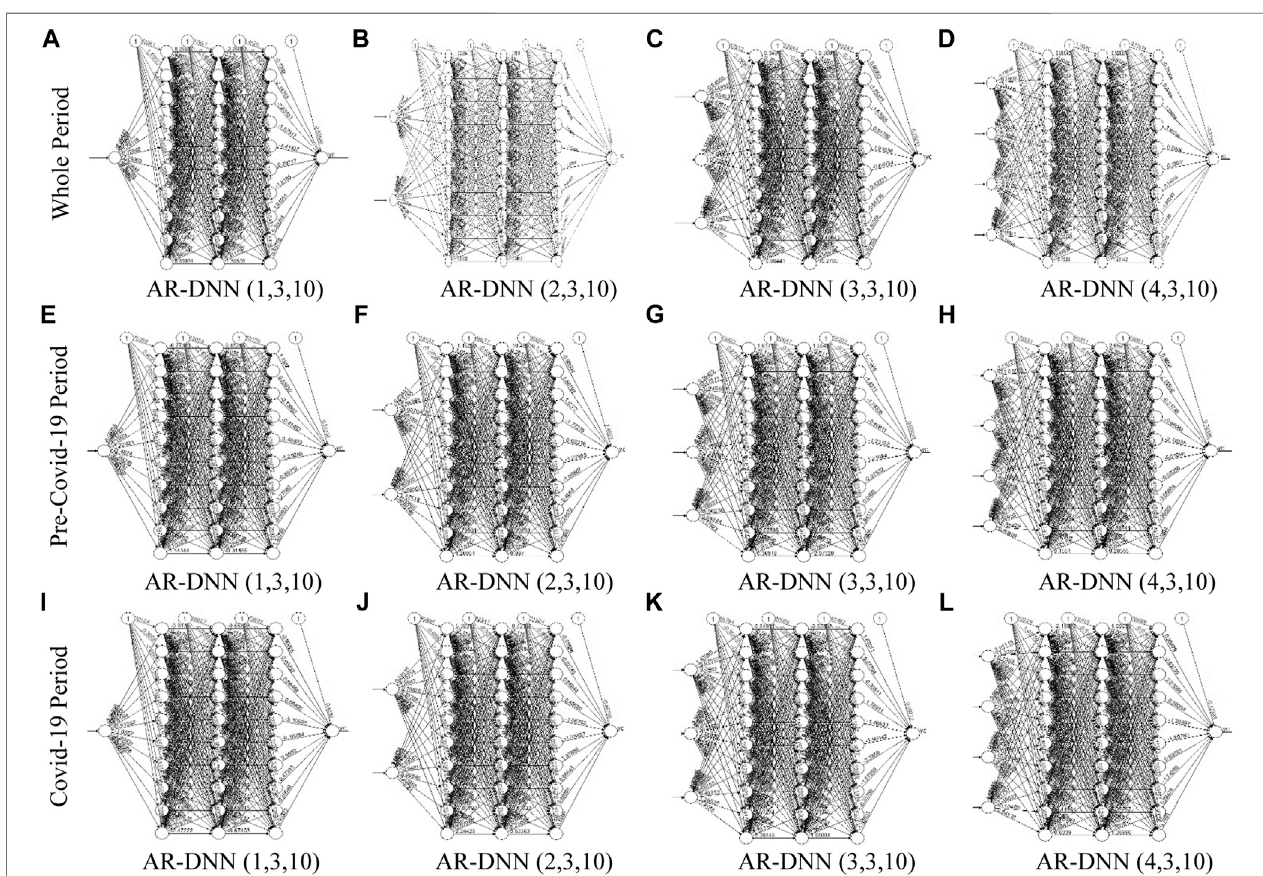
FIGURE 3 | Neural network plot with estimated model weights: (A) AR-DNN(1, 3, 10). (B) AR-DNN(2, 3, 10). (C) AR-DNN(3, 3, 10). (D) AR-DNN(4, 3, 10). (E) AR- DNN(1, 3, 10). (F) AR-DNN(2, 3, 10). (G) AR-DNN(3, 3, 10). (H) AR-DNN(4, 3, 10). (I) AR-DNN(1, 3, 10). (J) AR-DNN(2, 3, 10). (K) AR-DNN(3, 3, 10). (L) AR-DNN(4, 3,